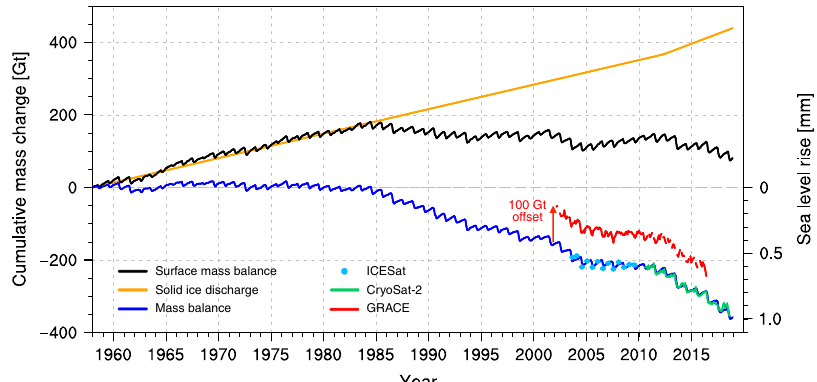
Fig. 2 Cumulative mass change of Svalbard glaciers and contribution to sea level rise. Time series of monthly cumulative modelled SMB, measured cumulative solid ice discharge ( D ) 11,12 and reconstructed cumulative mass balance (MB = SMB − D ) for the period 1958 – 2018. Observed mass change derived from GRACE (2002 – 2016), ICESat (2003 – 2009) and CryoSat-2 (2010 – 2018) are also shown. For clarity, GRACE data are shown with a positive offset of 100 Gt. The right y -axis translates Svalbard cumulative mass balance into global sea level rise equivalent. Supplementary Fig. 2c zooms in on the satellite period (2003 –